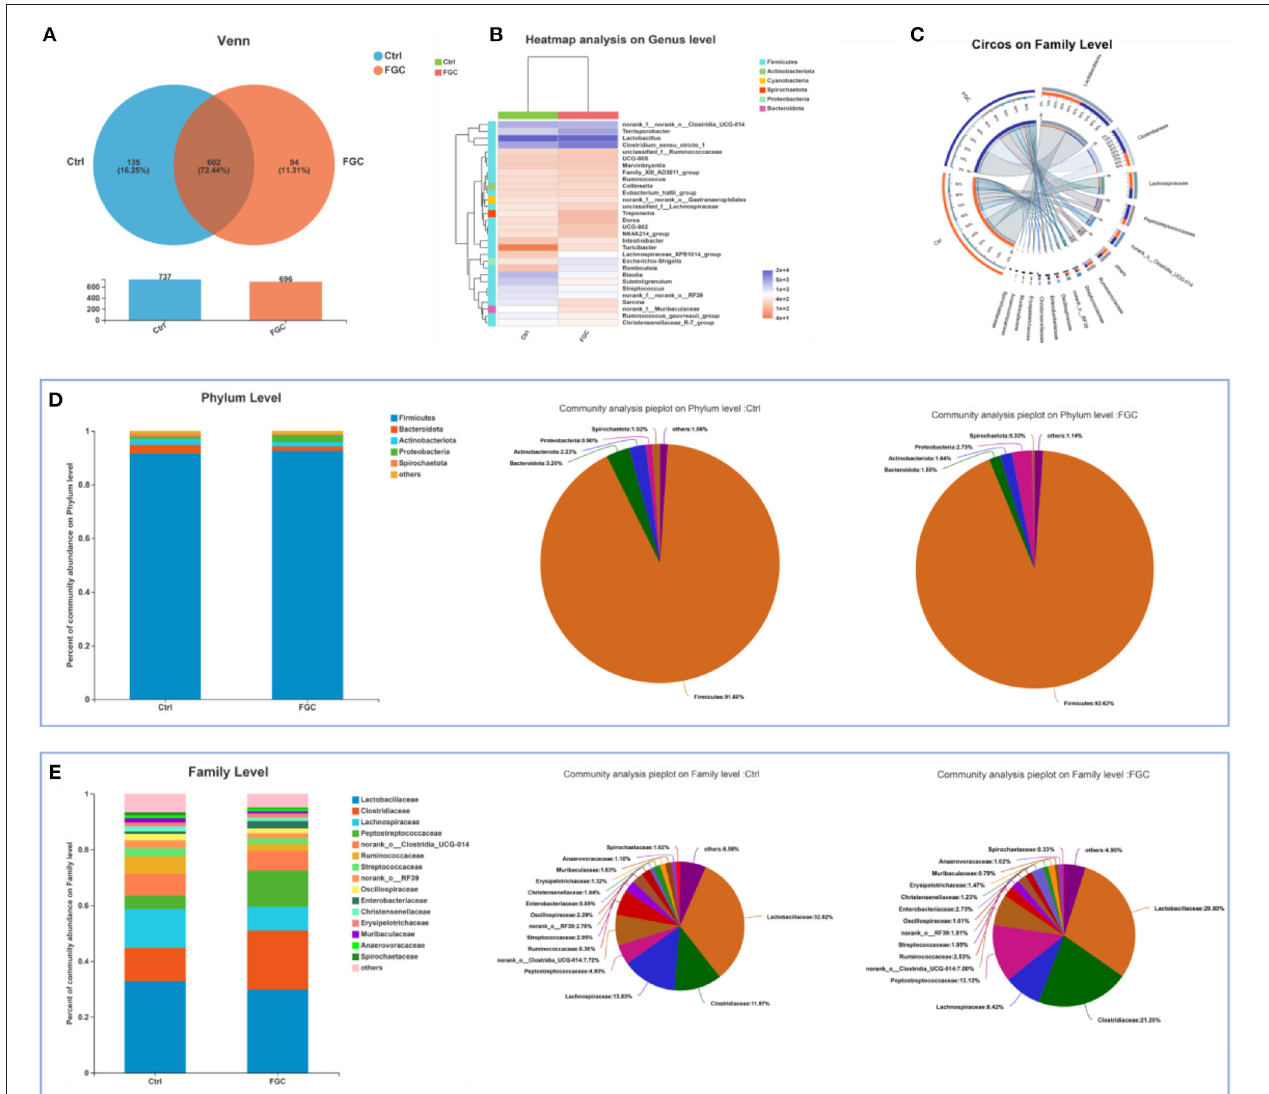
FIGURE 6 | Overview of fecal microbial composition of 28d-piglets. (A) Venn diagram. (B) Heatmap at genus level. (C) Circos diagram at family level. (D) Barplot and pieplot at phylum level. (E) Barplot and pieplot diagram at family level. Ctrl, corn-soybean basal diet; FGC, corn-soybean basal diet with 2,000 mg/kg ferrous glycine chelate. N =